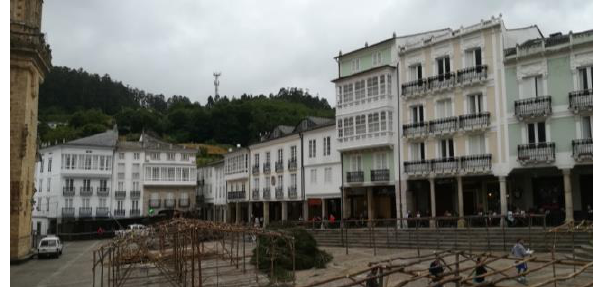
Figure 15. Houses with arcades in the main square, with half- timbered houses and their subsequent evolutions, among which is the Álvaro Cunqueiro House Museum. Source: A.F.P.